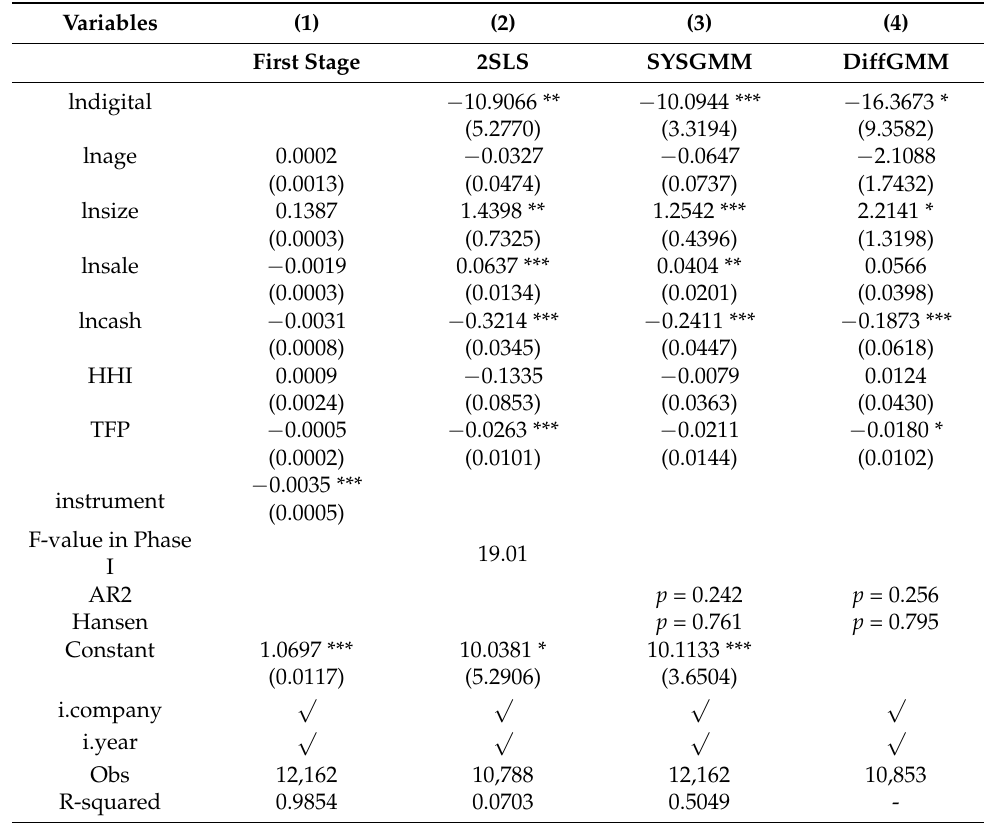
Table 5. Endogeneity